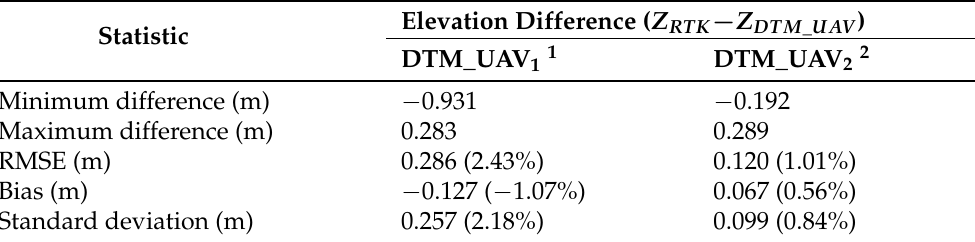
Table 2. Statistics for differences between altitudes collected in the field using an RTK system (Z RTK , n = 214) and those estimated from two UAV DTMs of a young Eucalyptus